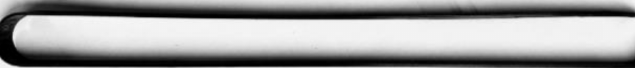
Figure 7. Finished strap